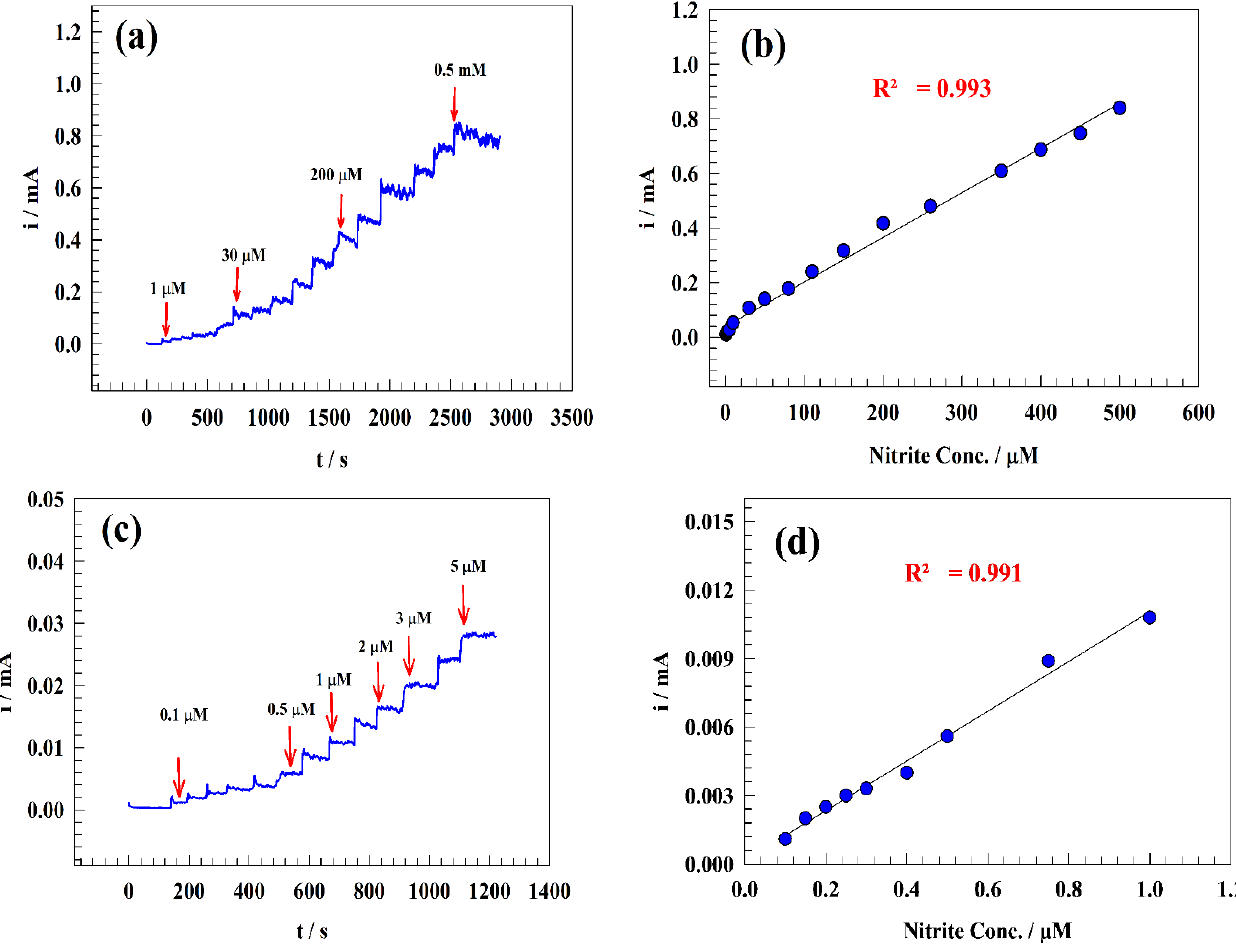
Figure 8. ( a ) Nyquist plots of modified electrode GC/PANI/NiOnF at constant AC potential of 1.0 V in the presence and absence of nitrite. ( b ) Nyquist plot of the modified GC/PANI/NiOnF at AC Potential of 1.0 V at different solution pH (2 – 10). Inset figures: the fitting circuits of the correspond- ing EIS result.